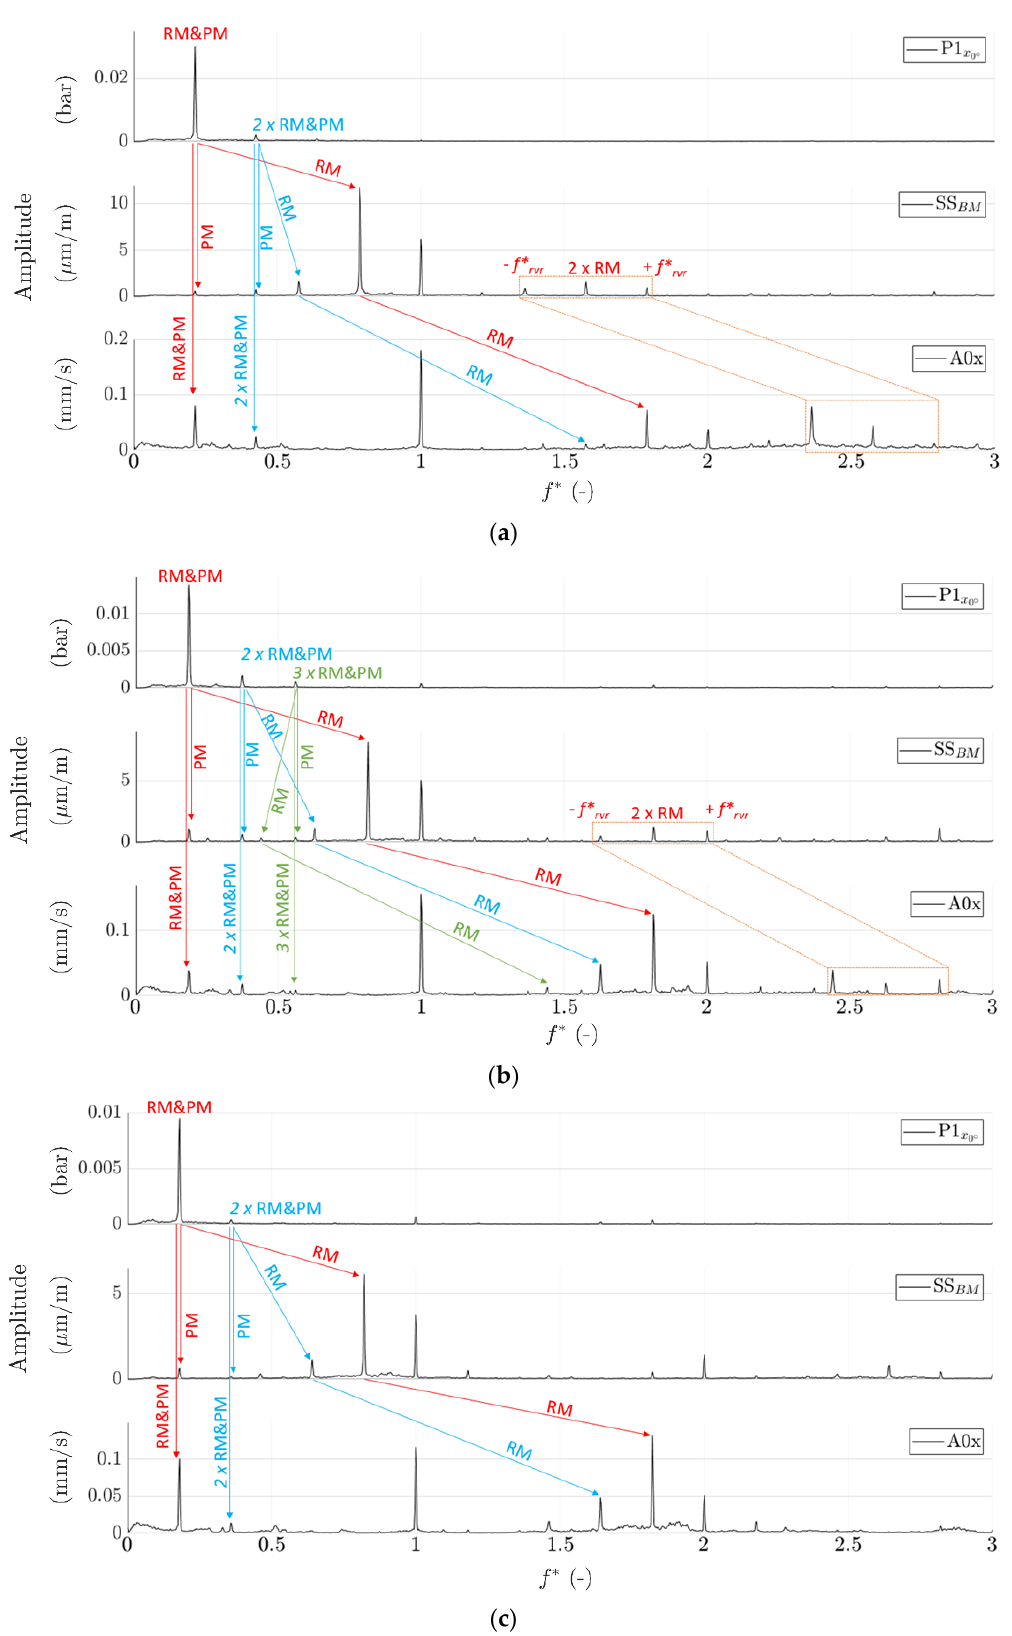
Figure 8. Spectra of the draft tube cone pressures below the runner (P1x 0° ), of the shaft bending strains (SS BM ) and of the draft tube cone velocity vibrations (A0x) at α of 15° ( a ), 18° ( b ), and 20° ( c ).